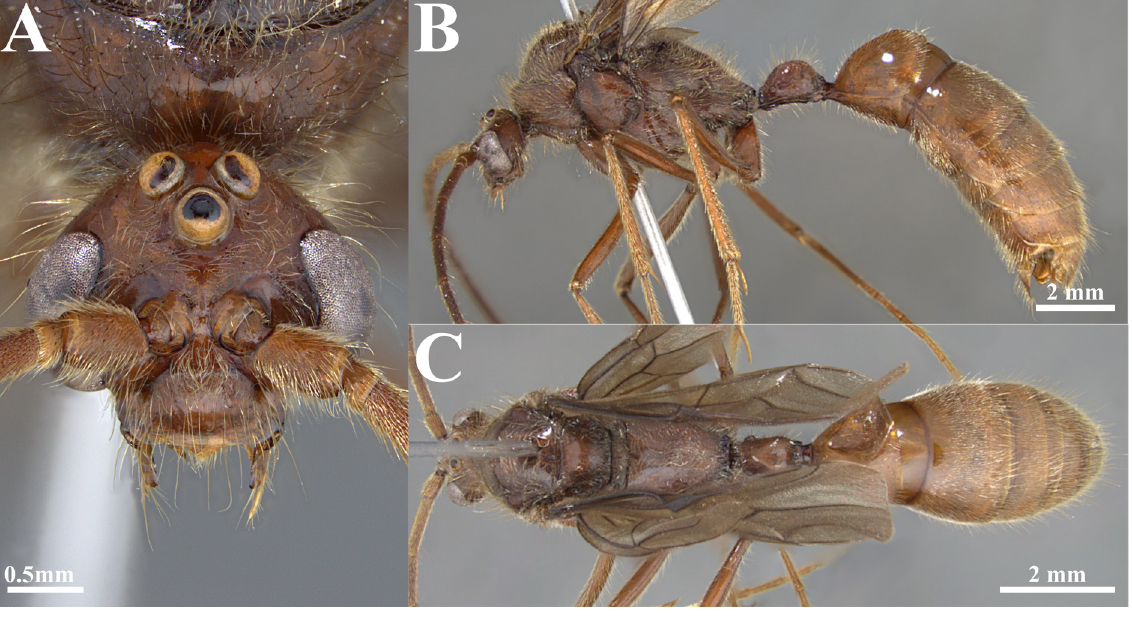
UFES 106427). A . Full-face view. B . Full body in lateral view. C . Full body in dorsal